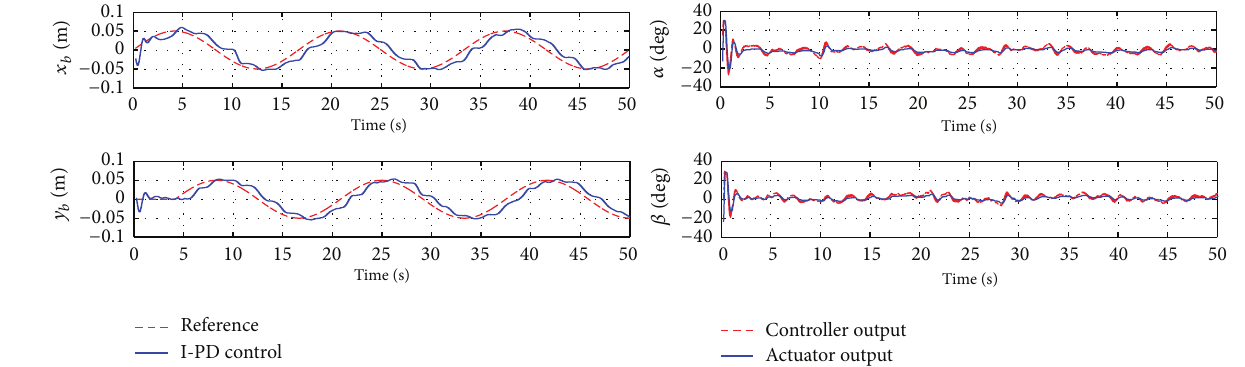
Figure 13: Experimental results of circle